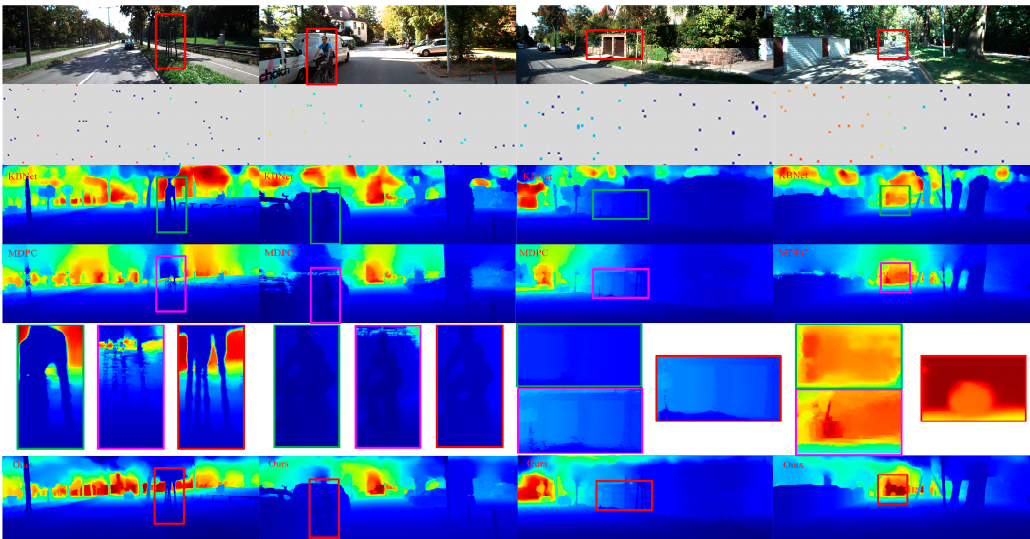
Figure 6. Qualitative results on the KITTI test set. Head-to-head comparison against [9,32]. Our method performs better in the regions with depth-mixing of small structures and the regions with obvious photometric changes in the distance. Note that the sparse depth images are enlarged for visualization and only the areas highlighted in red are shown. In line 5, the green boxes are partially enlarged images of the KBNet results, the pink boxes are partially enlarged images of the MDPC results, and the right red boxes are partially enlarged images of the results of our method.